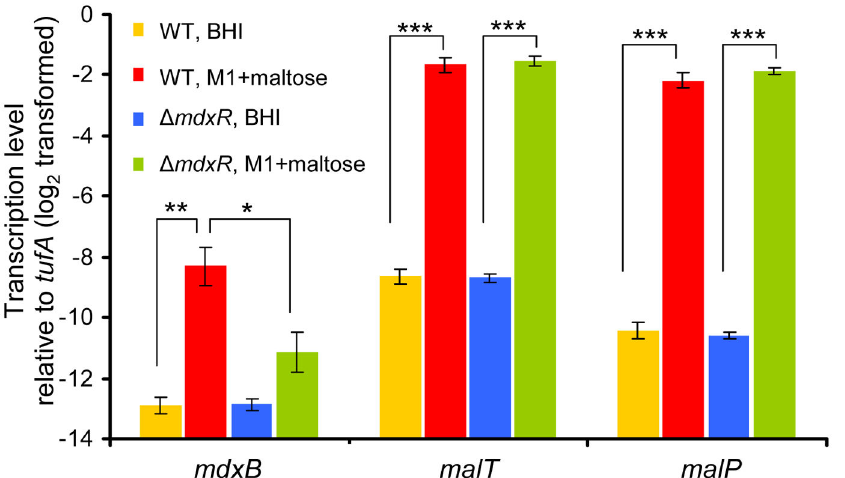
No significant difference in gene expression.